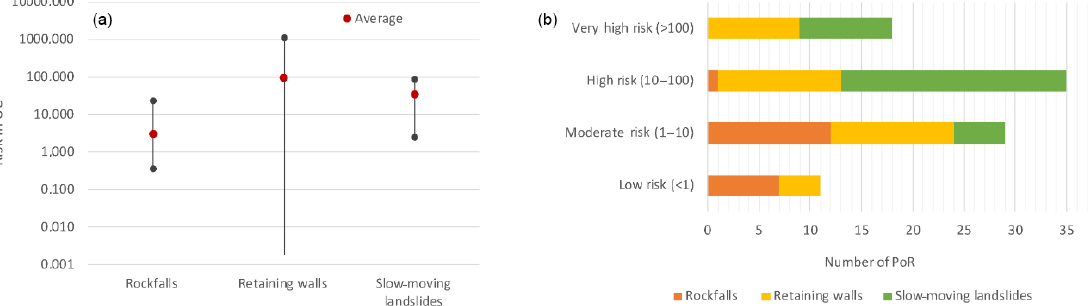
For slow-moving landslides with permanent or episodic activity, the landslide velocity was found to correlate well with the visible damage to the road pavement. The monthly thresholds of 3 and 10 mm and the cumulative displacement of 30 and 100 mm were used for the landslide intensity clas- sification (see Table